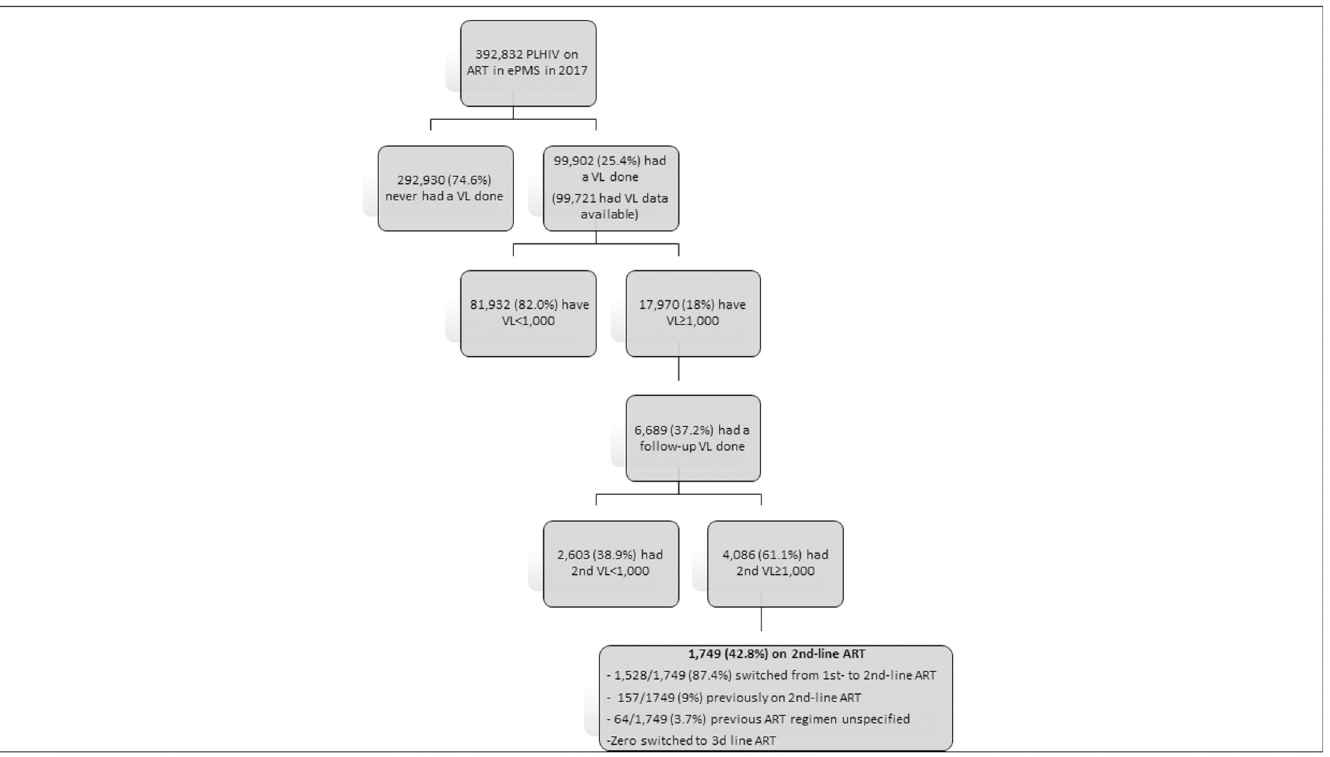
Fig 5. Flow chart showing the management of PLHIV still in ART care beyond 30 June 2017 and with unsuppressed viral load result in 2017 in the Zimbabwe ART program at health facilities using the electronic Patient Management System.